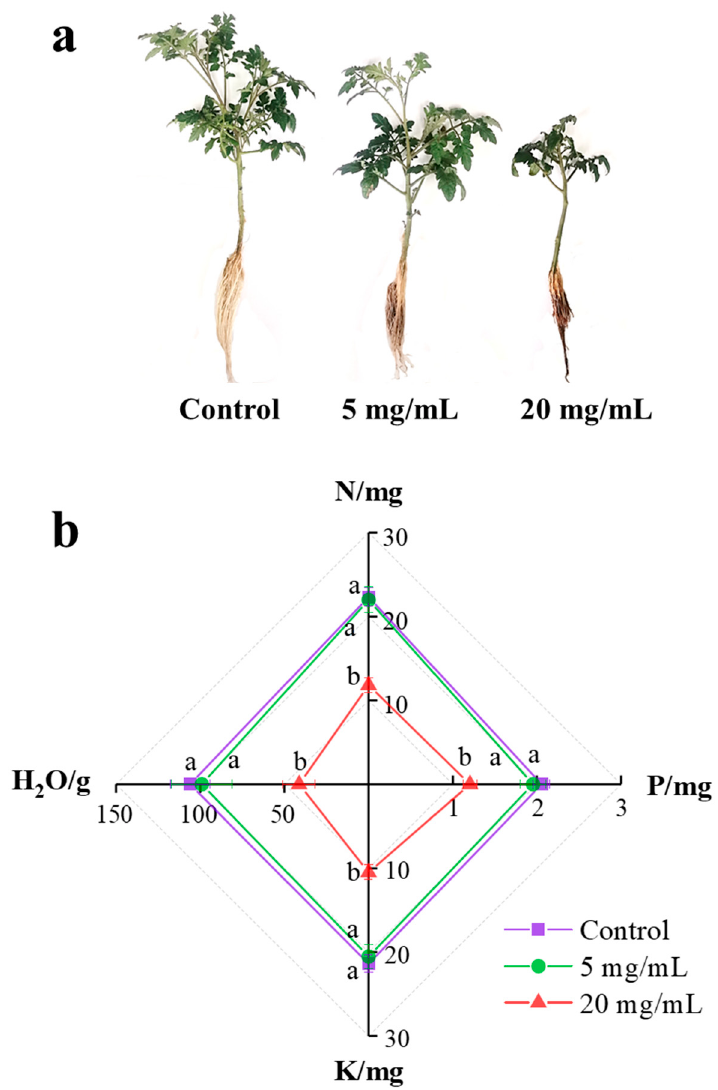
Figure 2. The growth ( a ) and available nutrient ( b ) (N, P and K) absorption of tomato seedlings after exposure to a C. camphora extract for 14 days. (The significant difference among treatments is marked with different letters, p < 0.05)